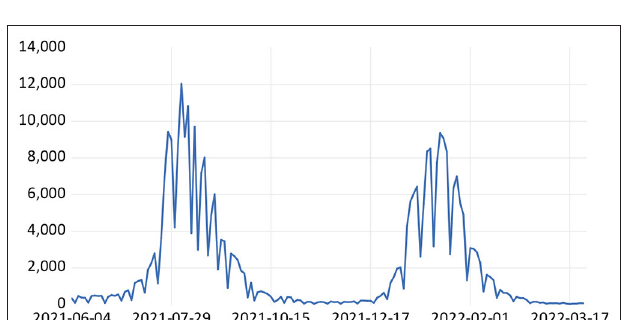
FIGURE 3 | COVID-19 daily new cases in Morocco.